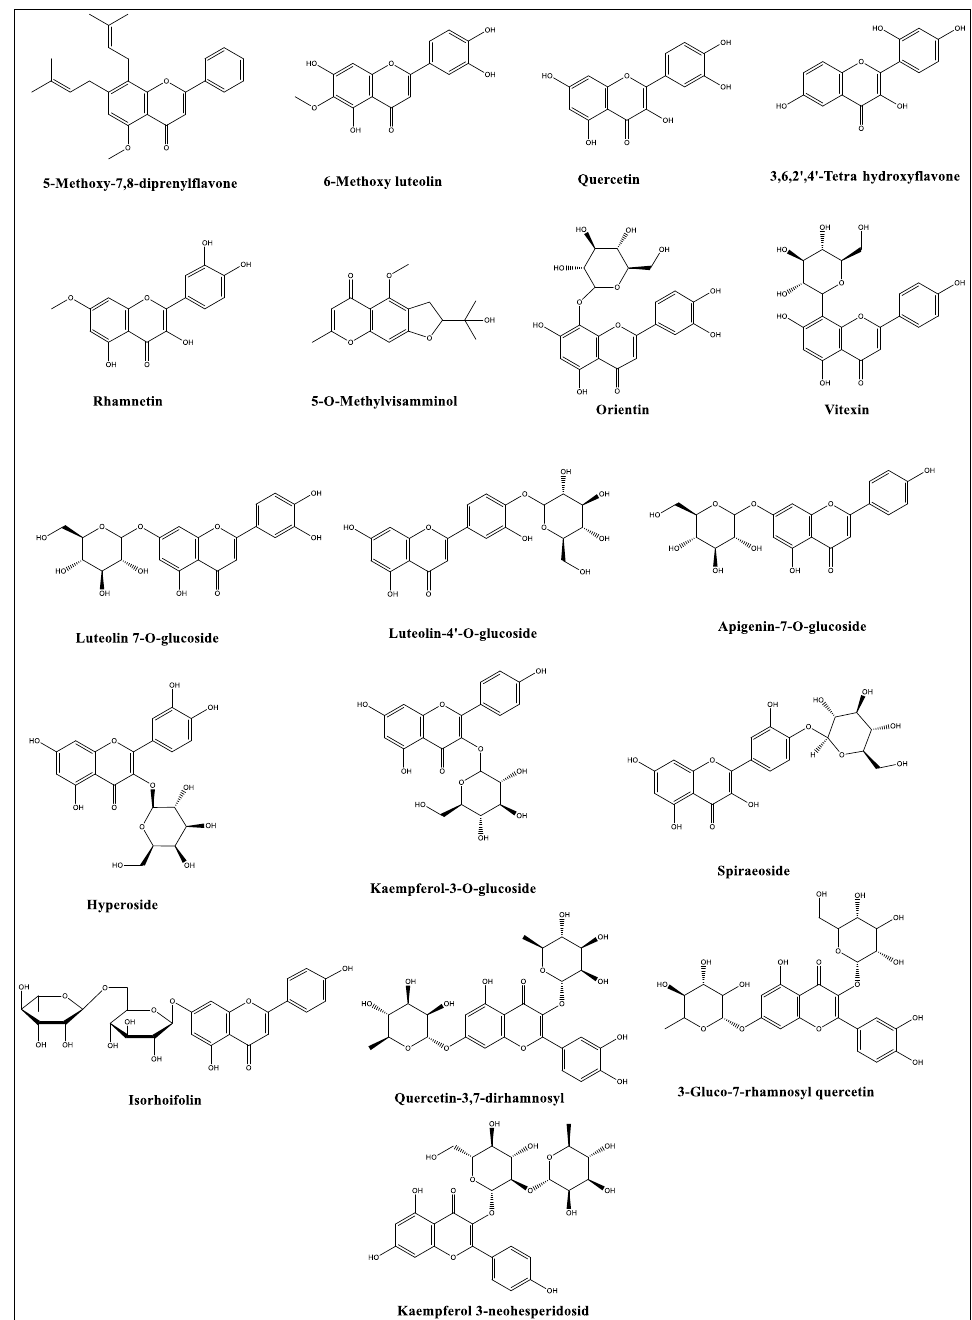
Figure 2. Structures of the flavonoid contents of the four halophytic plants.